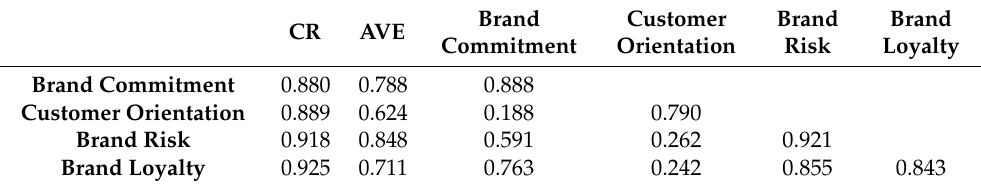
Table 7. Composite reliability and discriminant